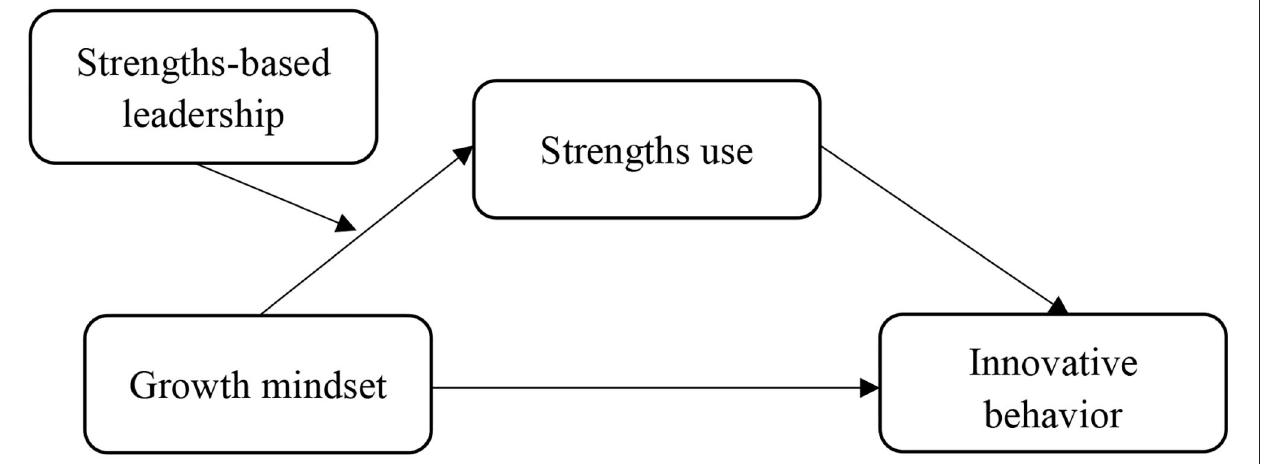
FIGURE 1 | The research model.